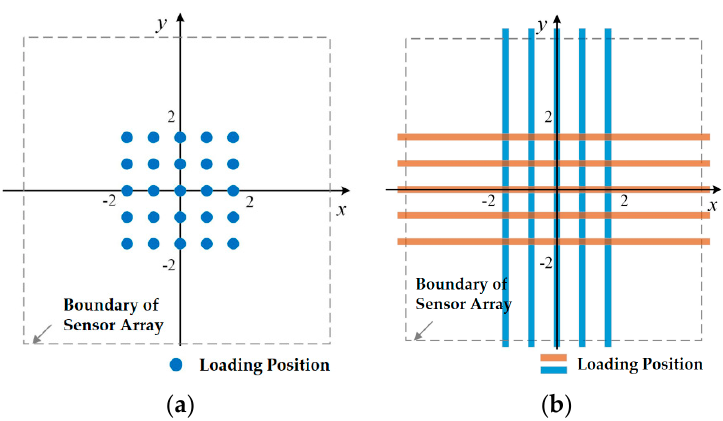
Figure 9. Loading position distribution of automatic object contact experiment: ( a ) loading position of plane and convex sphere; ( b ) loading position of convex cylinder.